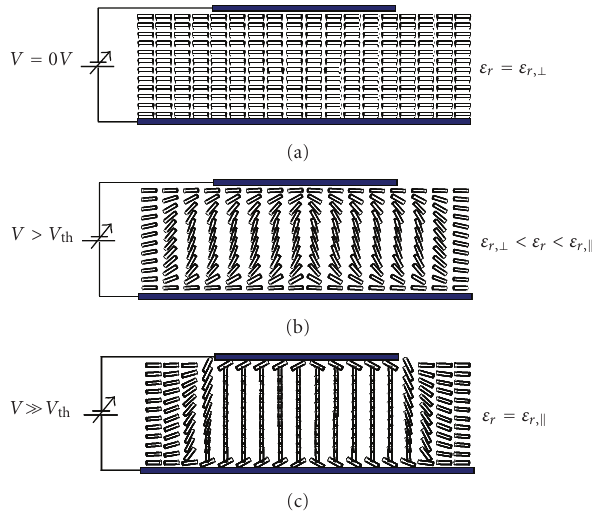
Figure 11: Functioning principle of the LC-tunable reflectarray unit cell with single microstrip